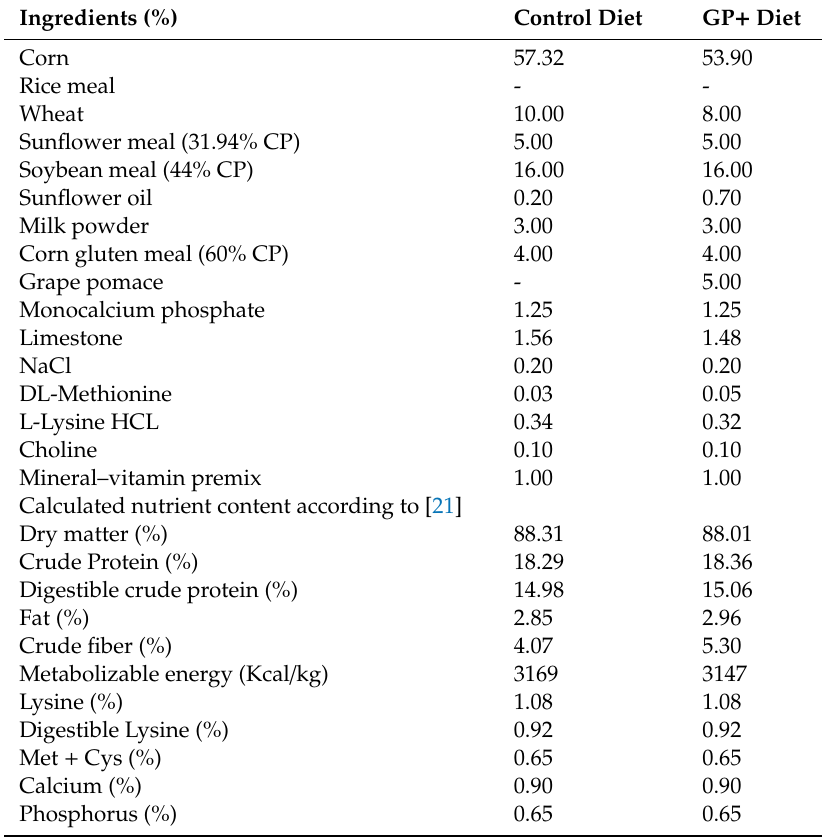
Table 1. Compound feed and calculated the nutrient content of experimental diets (%)